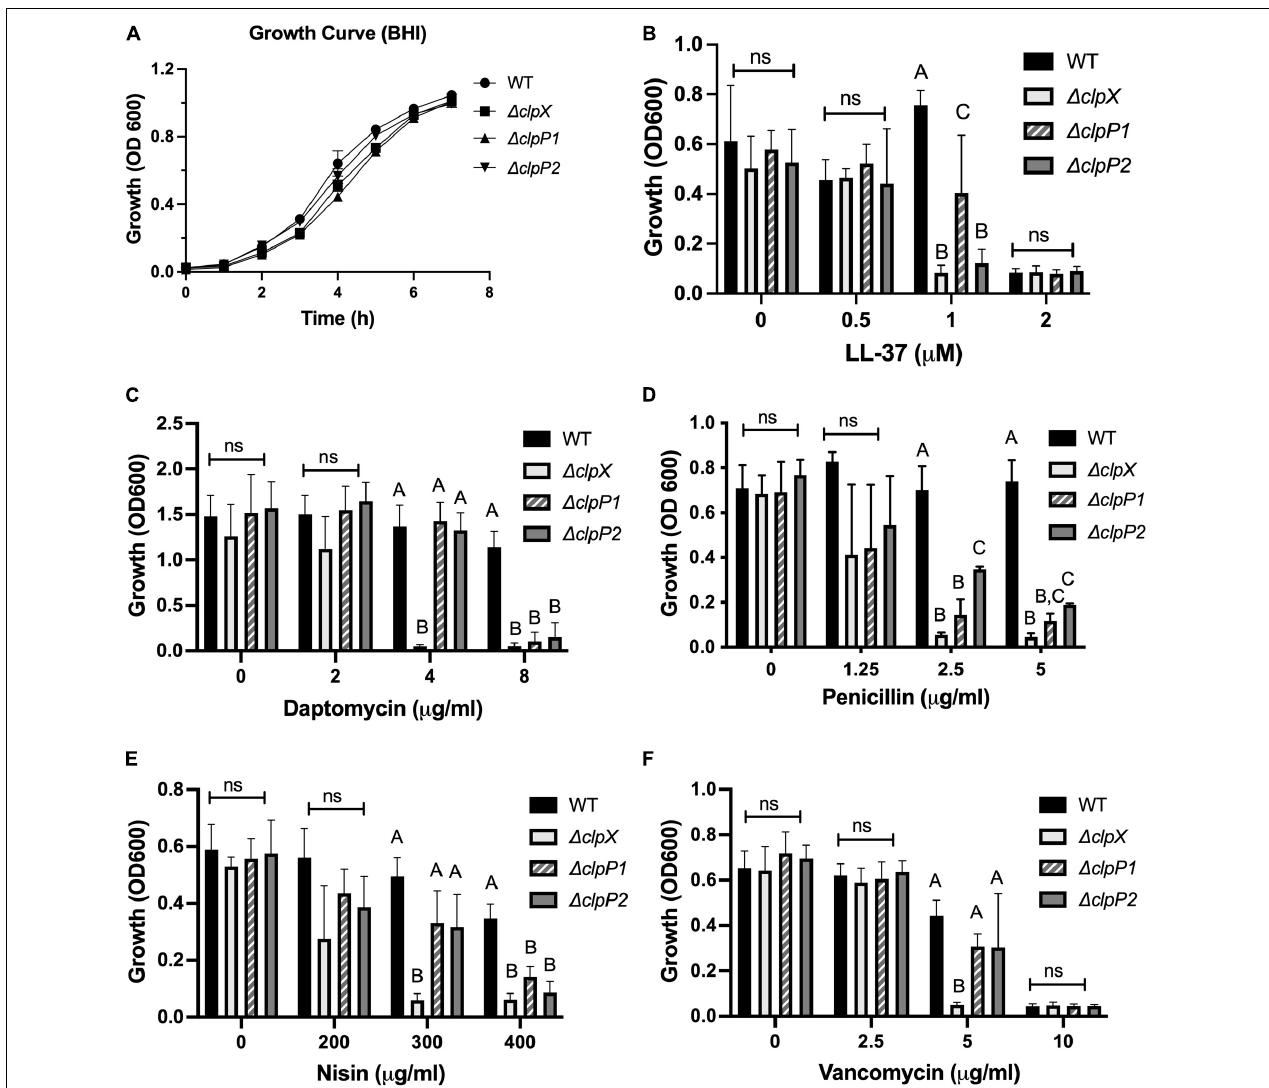
FIGURE 4 | ClpX, ClpP1, and ClpP2 contribute to antimicrobial resistance to varying degrees. Growth of wild-type B. anthracis Sterne (WT), (cid:49) clpX, (cid:49) clpP1 or (cid:49) clpP2 in (A) BHI alone or growth overnight in media containing either (B) LL-37, (C) daptomycin, (D) penicillin, (E) nisin, or (F) vancomycin. Statistical significance determined by one-way ANOVA followed by Tukey–Kramer post hoc analysis. Different numbers represent statistically significant differences ( p < 0.05) and ns means no statistical difference within each treatment group. Data are presented as mean ± SD. The growth curve was repeated twice; all other assays were repeated at least three independent